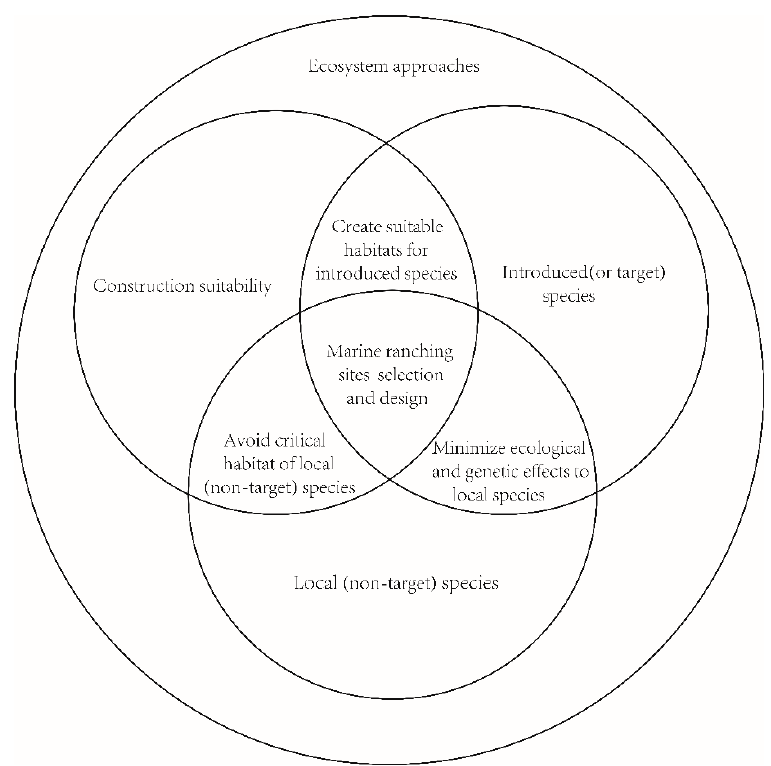
Figure 3. Conceptual diagram of the ecosystem approaches to marine ranching in the ECS.